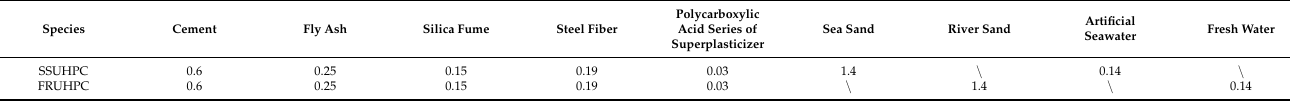
Table 5. Composition of raw materials with different ratios (mass